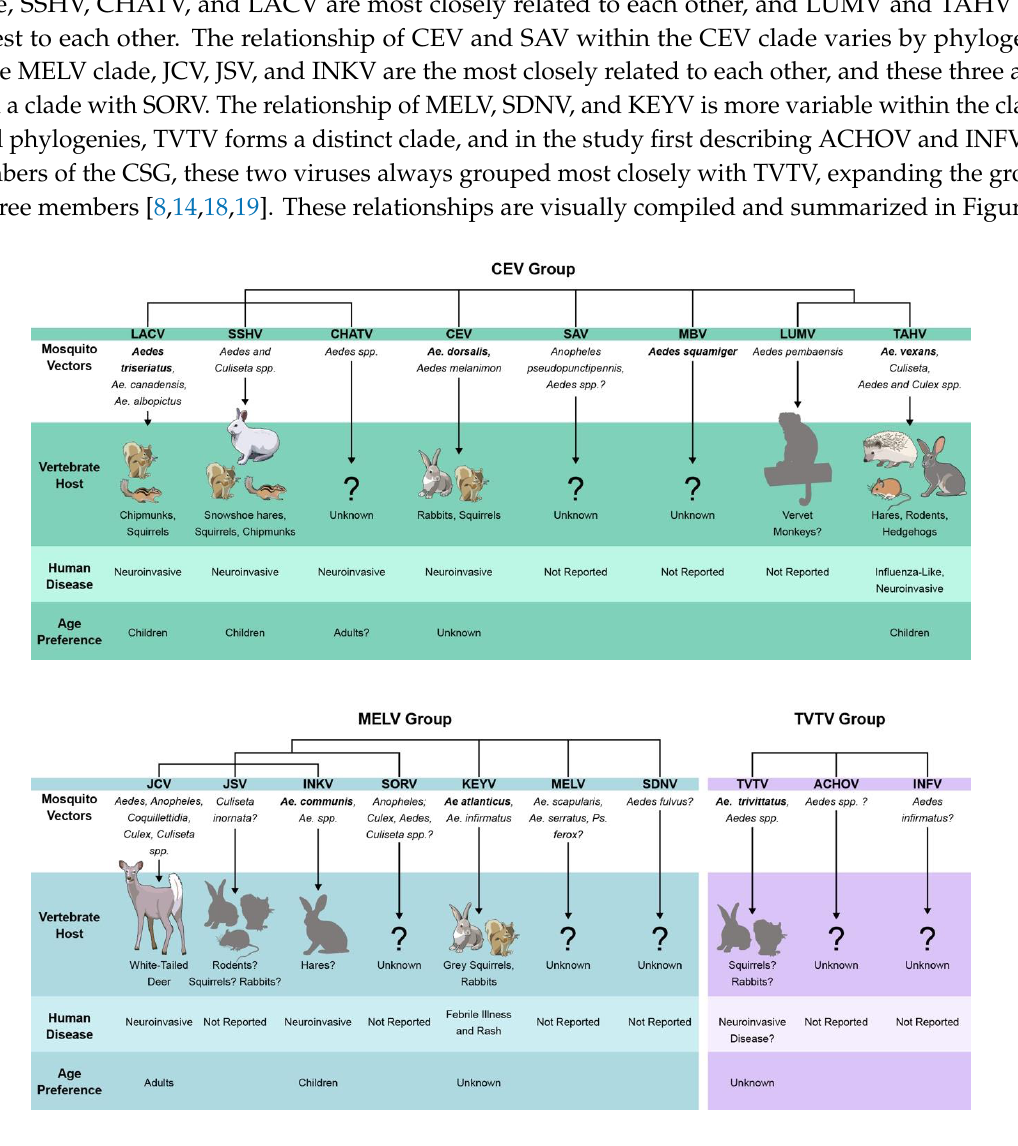
Figure 1. Summary of the genetic relationships, mosquito vectors, vertebrate hosts, and human disease for the California serogroup (CSG) viruses, expanded from Figure 1B in [21]. Groups are divided